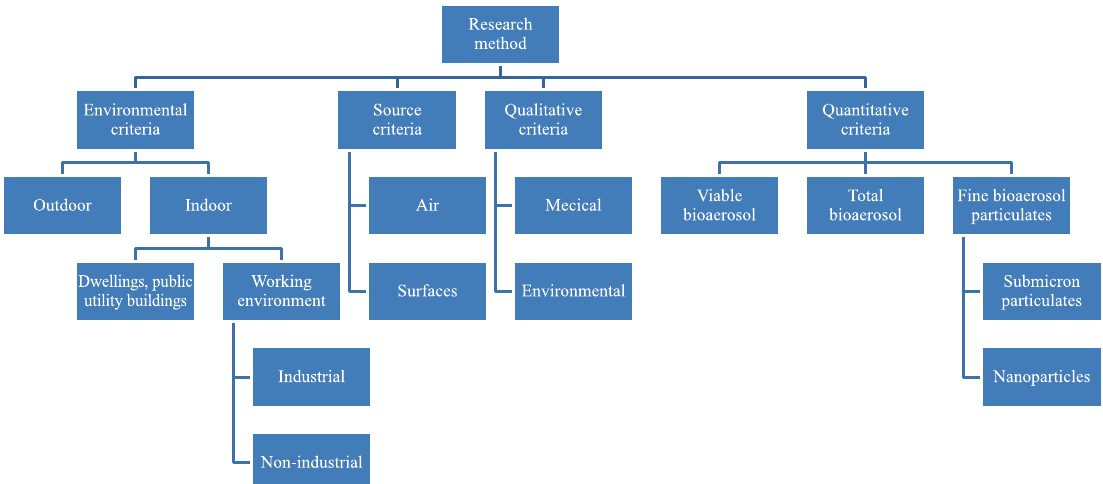
Fig. 3 Key factors in the elaboration of threshold limit values for microbial